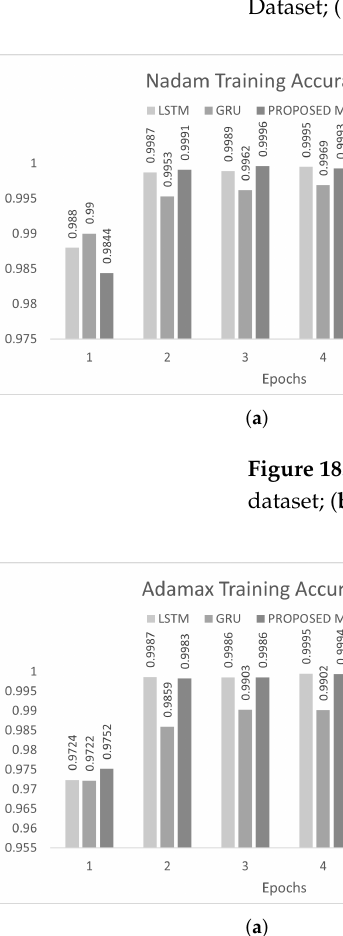
Figure 17. Adam training on the car-hacking dataset. ( a ) Adam training accuracy on car-hacking. Dataset; ( b ) Adam training loss on car-hacking. Dataset.